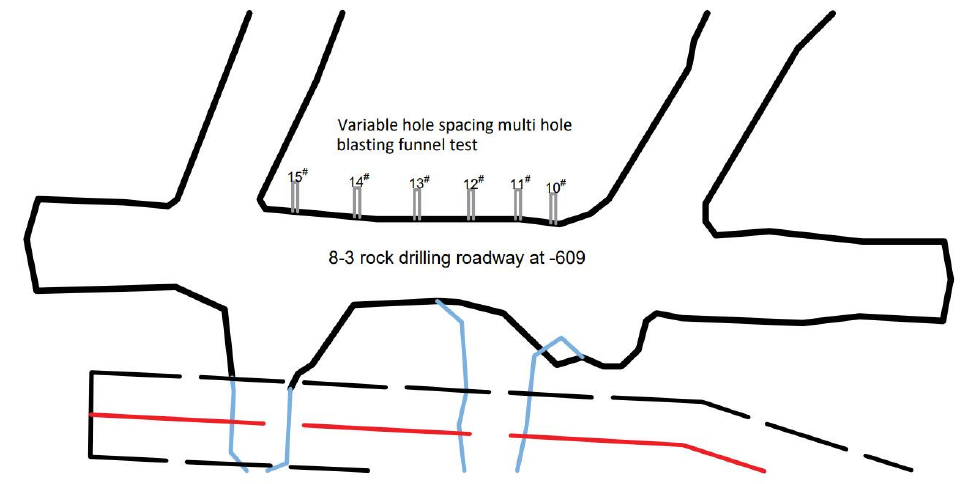
Figure 3. Schematic diagram of blast hole plane layout in funnel test of multi-hole blasting with variable hole distance. (In the figure, ‘ # ’ is for the convenience of numbering the holes, 10 # represents hole number one, and so on).